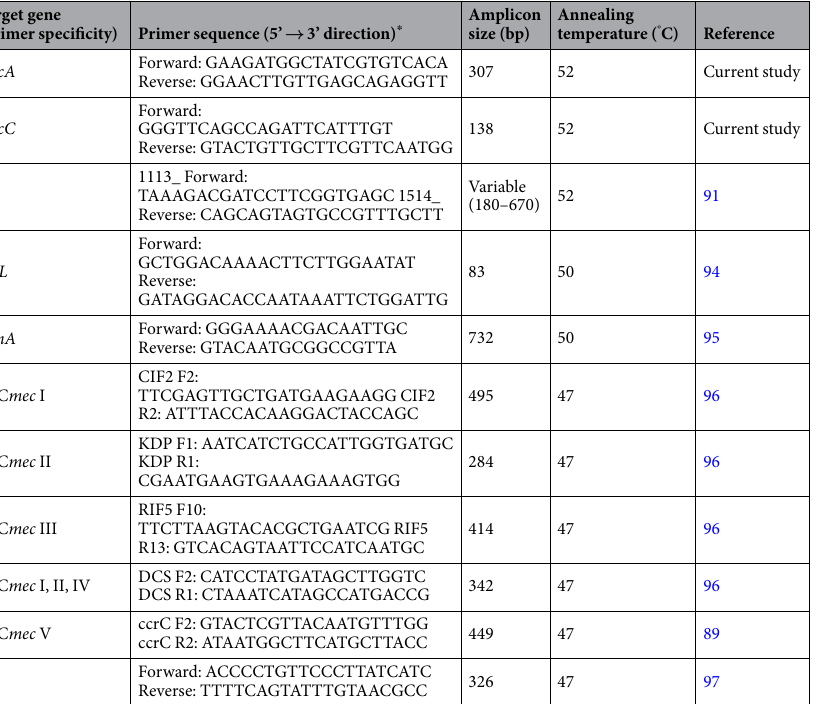
Table 8. PCR primers used in this study. * F: forward primer; R: reverse